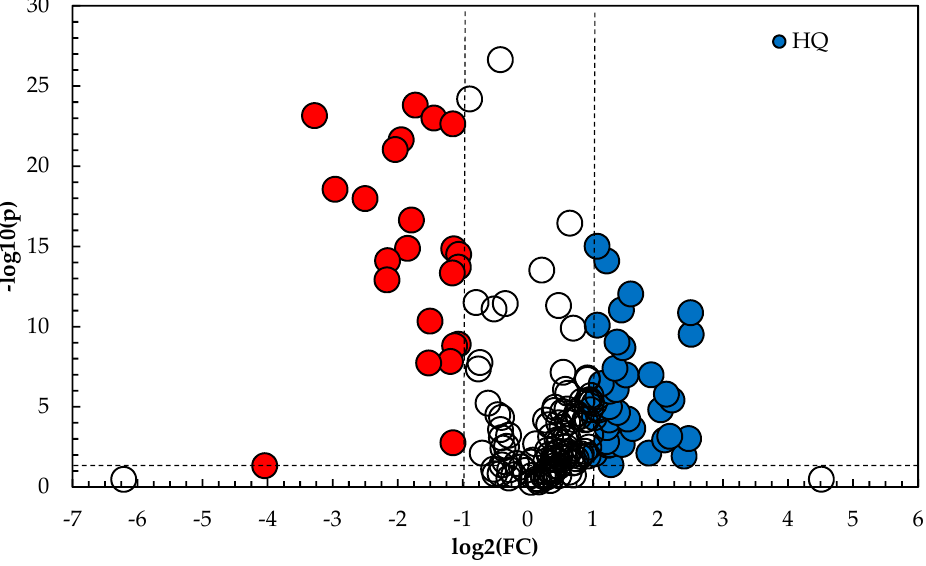
Figure 4. Volcano plot of the analyzed lavender oil samples by untargeted GC-MS.